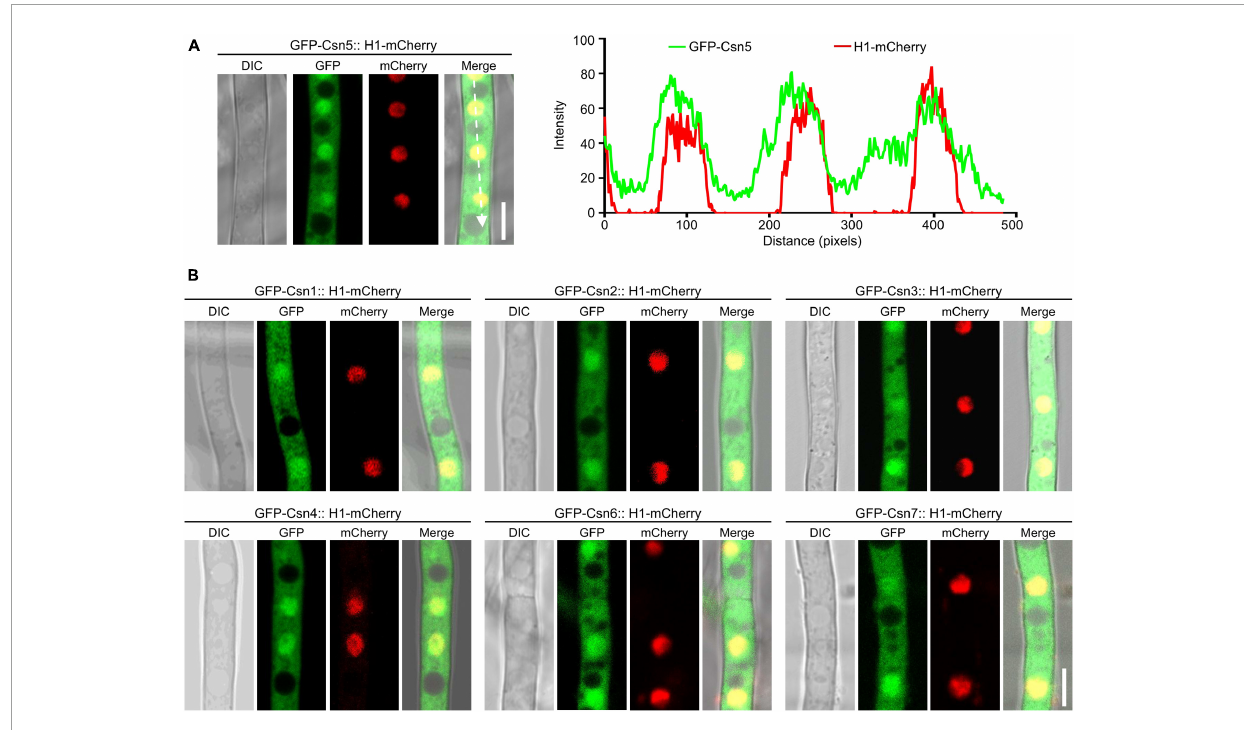
FIGURE3 The localization of the Csn subunits in hyphae of F. graminearum . (A) Micrographs showing the localization of GFP-Csn5 in hyphae of F. graminearum after growth in liquid complete medium (CM) for 16 h. H1-mCherry was used to visualize the nuclei. Bar = 5 µ m. A line scan graph was generated at the indicated position (arrow) to show the relative localization of GFP-Csn5 (green) and H1-mCherry (red). (B) Micrographs showing the localization of six Csn subunits in hyphae of F. graminearum . Bar = 5 µ